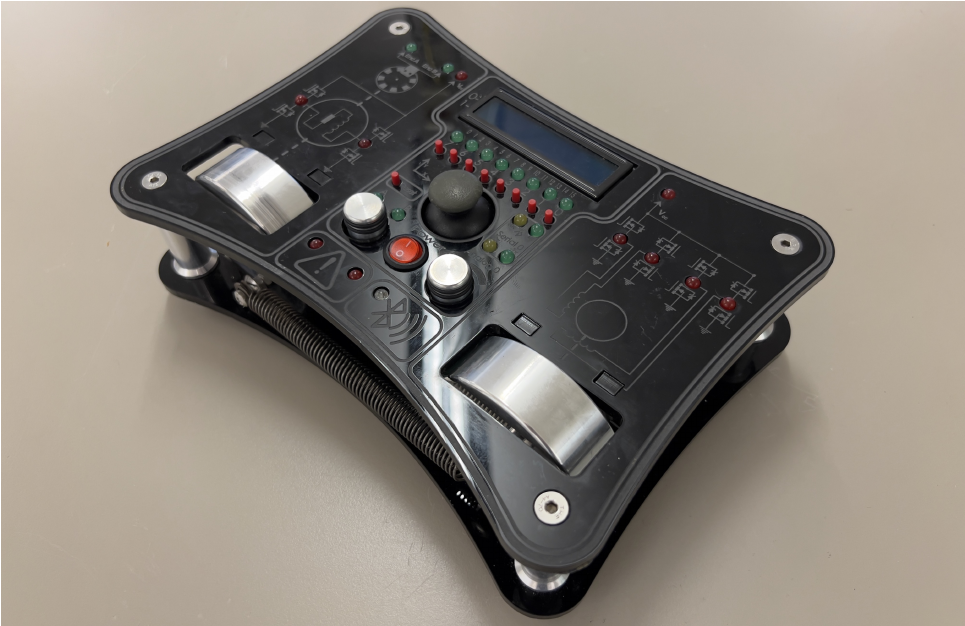
Figure 2. The all in one servo lab